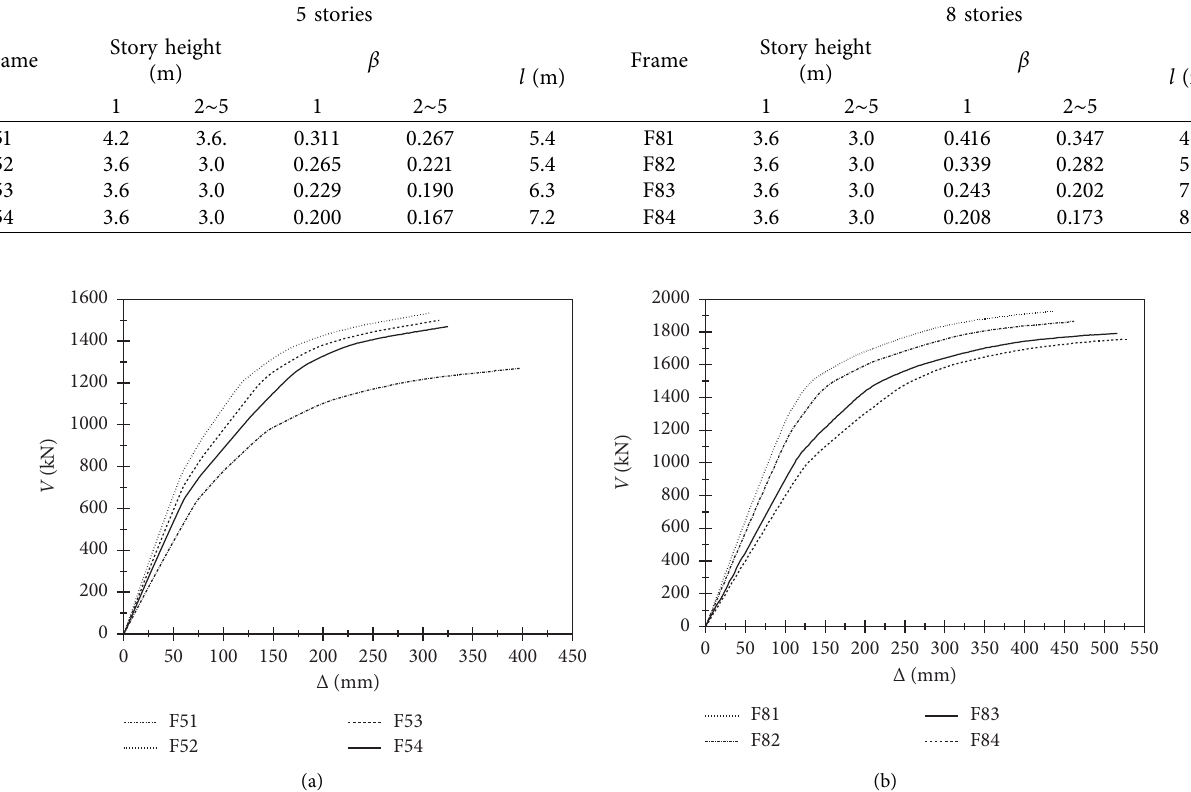
Figure 8: Capacity curves of structures with different β . (a) 5 stories. (b) 8 stories.